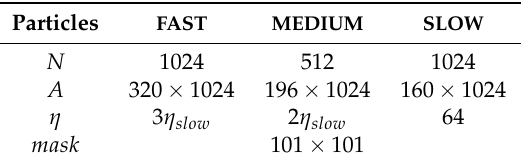
Table 2. Simulation parameters for model 4. Particle types in the top row and related parameters in the rows below with: N their respective number, A the initial area (in pixels) on which their are positioned and η their diffusion constant.